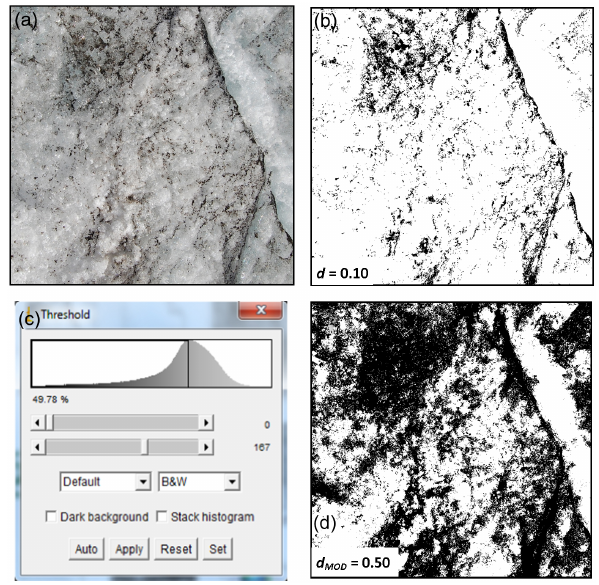
Figure 11. Comparison between the application of the threshold chosen correctly by the user, T GS (b) , and the one corresponding to the most frequent grey tone, T GS-MOD (d) , deducted by the fre- quency distribution curve (c) . The relative d and d MOD values are shown in (b) and (d) . In (a) , the analyzed surface is